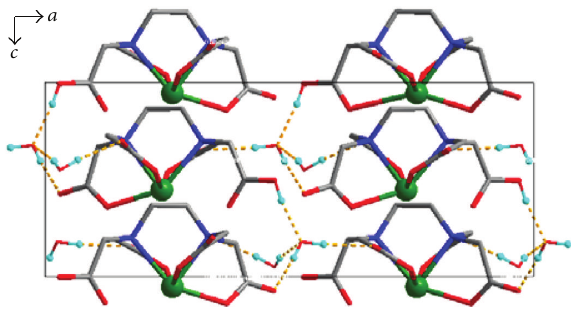
Figure 3: Packing diagram of the title complex showing H bonding along the b axis.